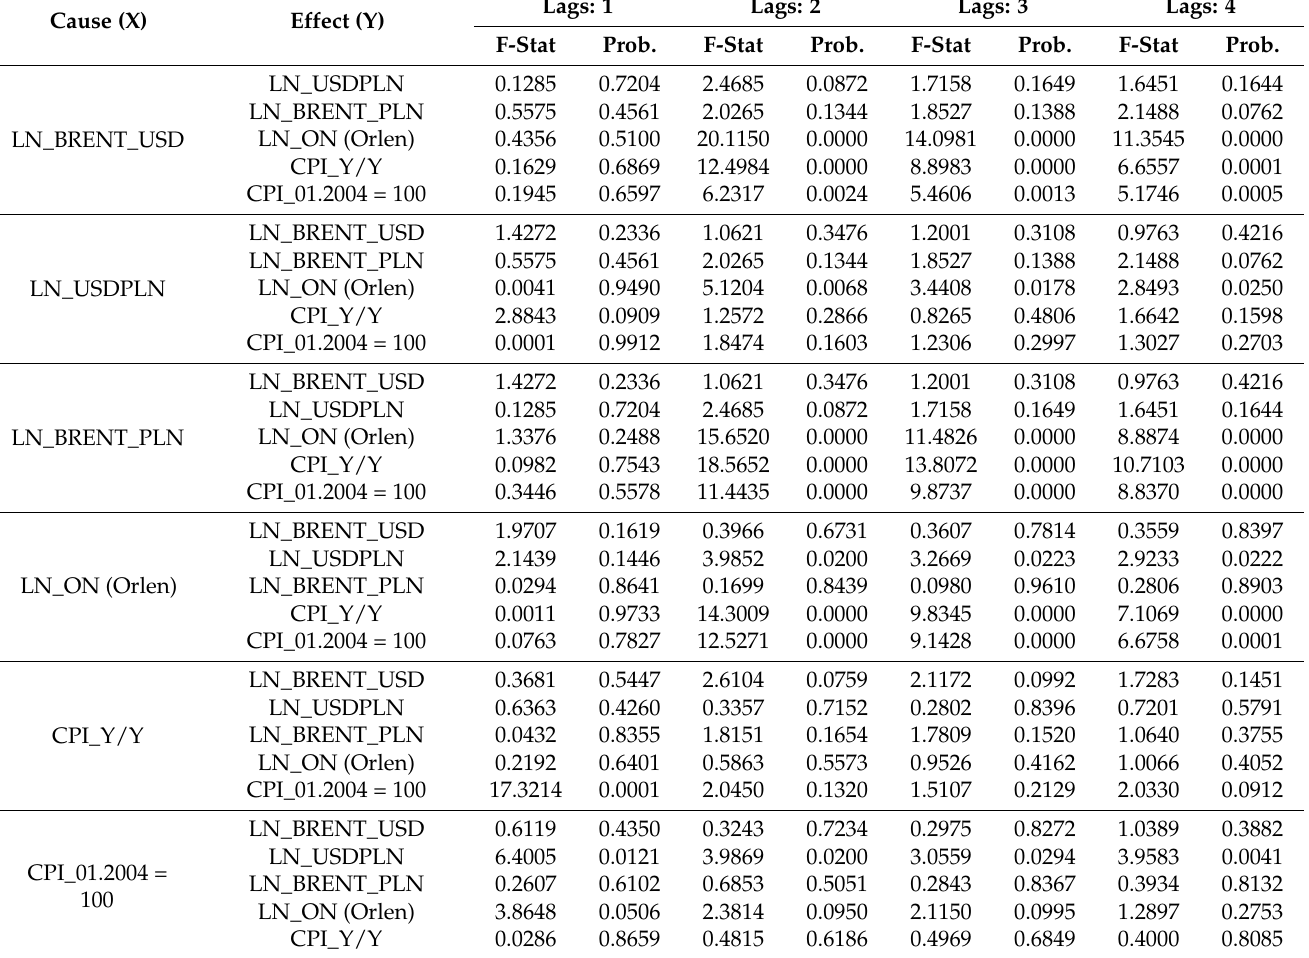
Table 4. Causality